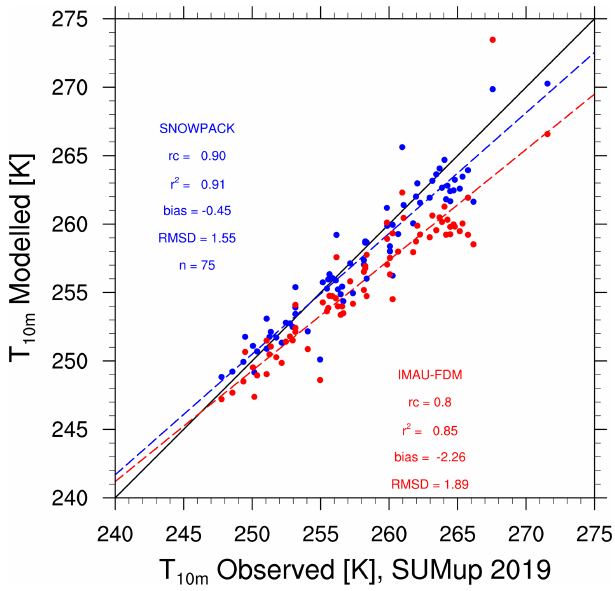
Figure 2. Modelled IMAU-FDM (red), SNOWPACK (blue), and RACMO (black) 10m snow temperature as a function of observed 10m snow temperature. Modelled temperature is corrected for dis- crepancies in elevation using a lapse rate of 7.2Kkm − 1 . Statistics (slope (rc), r 2 (with significance level p < 0 . 0001), bias, and root- mean-square deviation (RMSD)) for SNOWPACK, IMAU-FDM, and RACMO-FDM are denoted based on all 75 locations. Observa- tions are from Montgomery et al. (2018) and selected as described in Sect.